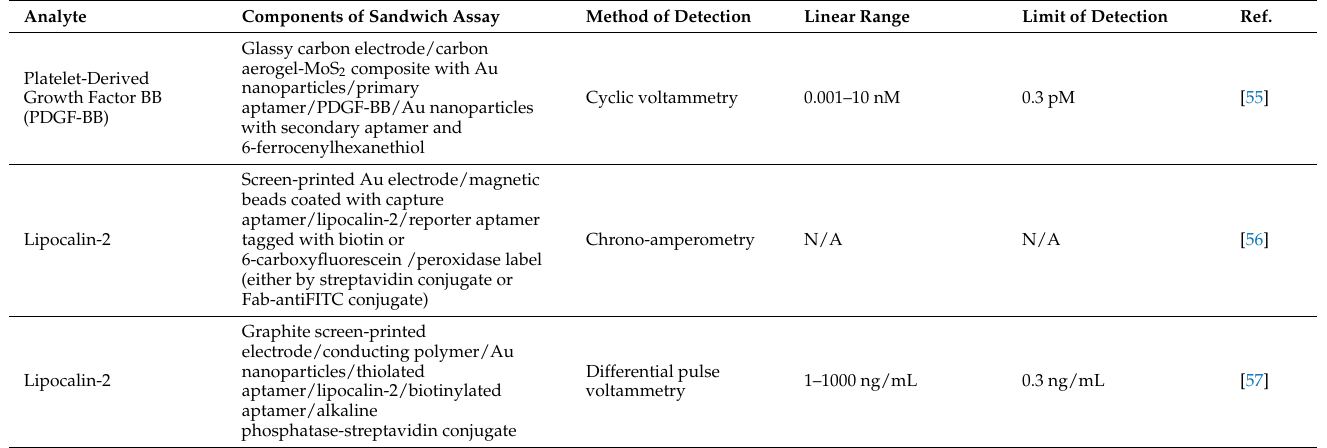
Table 2. Electrochemical Sandwich Assays Using Two